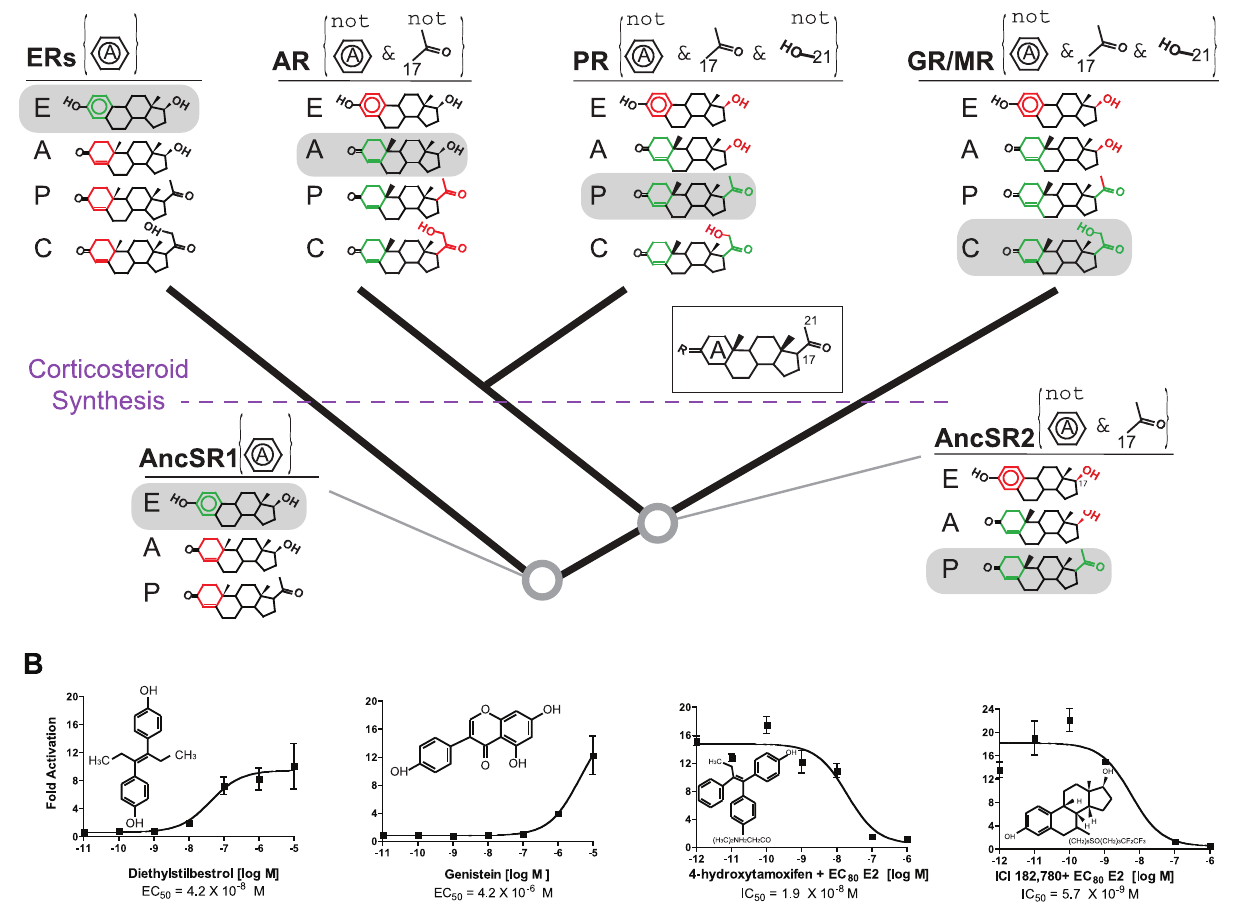
Figure 3. Evolution of minimal specificity. A, Evolution of ligand-recognition criteria on the SR phylogeny. For each ancient and extant receptor, the criteria that distinguish activating ligands from other endogenous steroids are shown in brackets. Rules labeled ‘‘not’’ indicate significantly strongly reduced sensitivity when the specified moiety is present; other rules indicate strongly increased sensitivity when the moiety is present. The structures of representative endogenous hormones – estrogens (E), androgens (A), progestagens (P) and corticosteroids (C) – that were synthesized at each point in time are shown. Green portions of each hormone show moieties that satisfy the receptor’s rules; red portions violate rules. Each receptor’s rules are sufficient to allow activation by only a single class of hormones (gray boxes). The evolution of corticosteroid synthesis is indicated; AncSR2’s criteria would not have been sufficient to distinguish corticosteroids from progestagens. Inset: common steroid structure with A-ring and key carbons labeled. Dose-response curves for extant receptors are shown in Figure S7. B, AncSR1 is activated/antagonized by xenoestrogens in a luciferase reporter assay. IC50, concentration at which half-maximal inhibition was achieved in the presence of estradiol (EC 80 =200 nM). Each point shows the mean and SEM of three